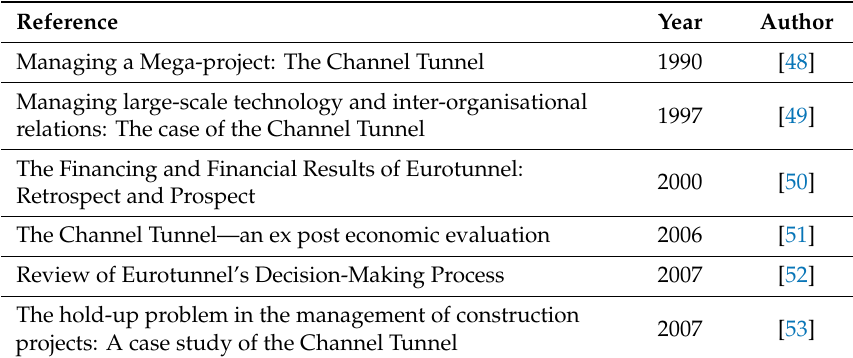
Table 3. Key references used to develop a